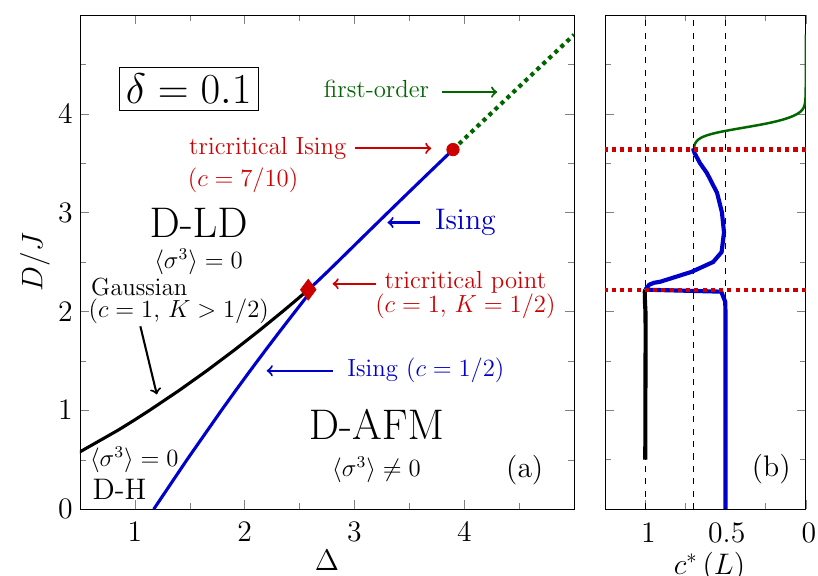
Figure 1: (a): Ground-state phase diagram of the model (2) for δ = 0.1. The error bar of the tricritical (Ising) point is smaller than the symbol size. 〈 σ 3 〉 denotes the third Ising order parameter, determining the Ising QPT between the D-H or D-LD phase and the D-AFM phase. (b): Numerically obtained central charge c ∗ ( L ) on various phase transition lines from Eq. (3) with L = 128 and periodic boundary